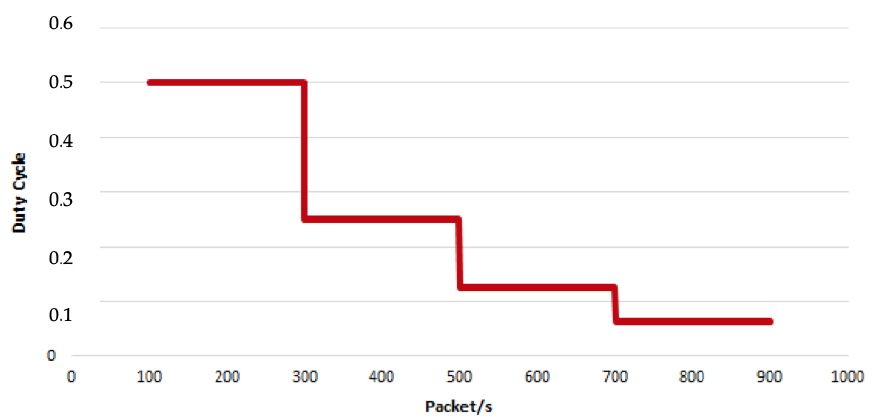
Figure 5. Duty cycle.